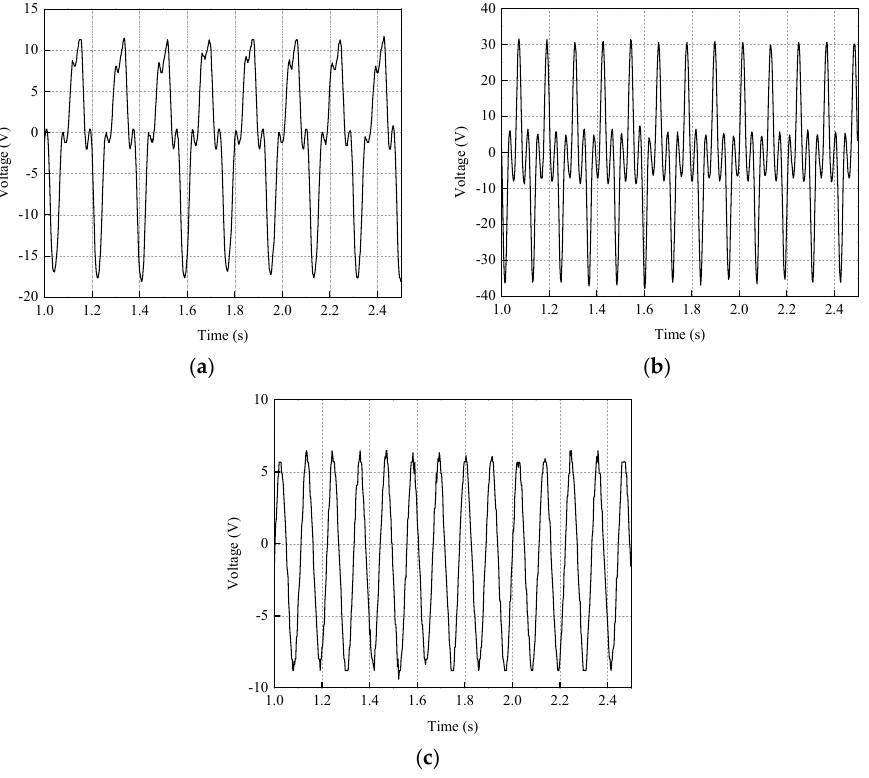
Figure 12. Time histories of voltages at different excitation frequencies: ( a ) 5.5 Hz; ( b ) 8.5 Hz; and ( c ) 10 Hz.